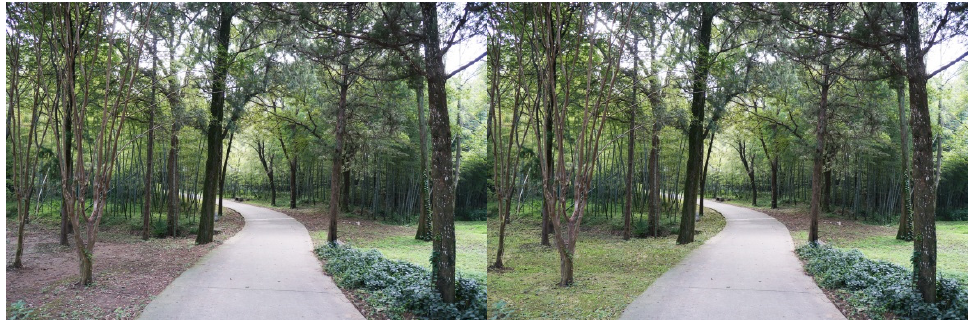
Figure 3. Example: Ground cover plants (grass of similar texture was added to the side with bare ground).